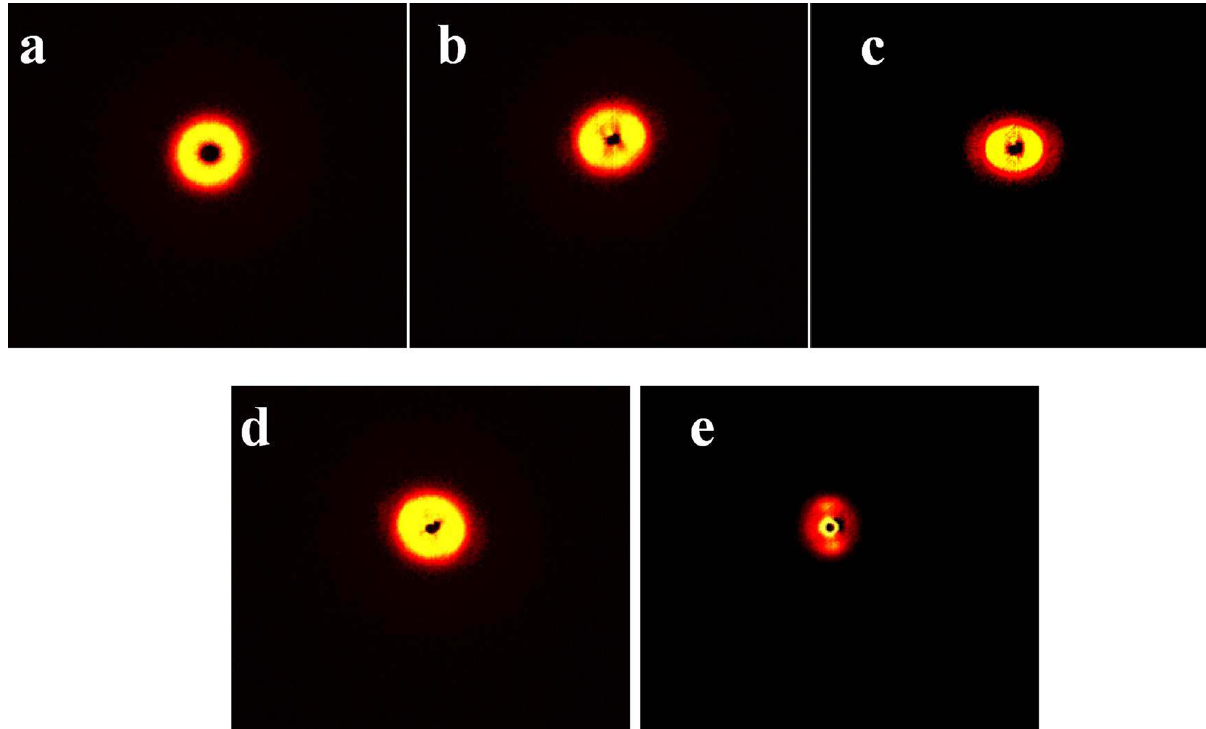
Figure 9: Small - angle di ff raction patterns of ( a ) iPP, ( b ) iPP/S0, ( c ) iPP/S1, ( d ) iPP/S2, and ( e )